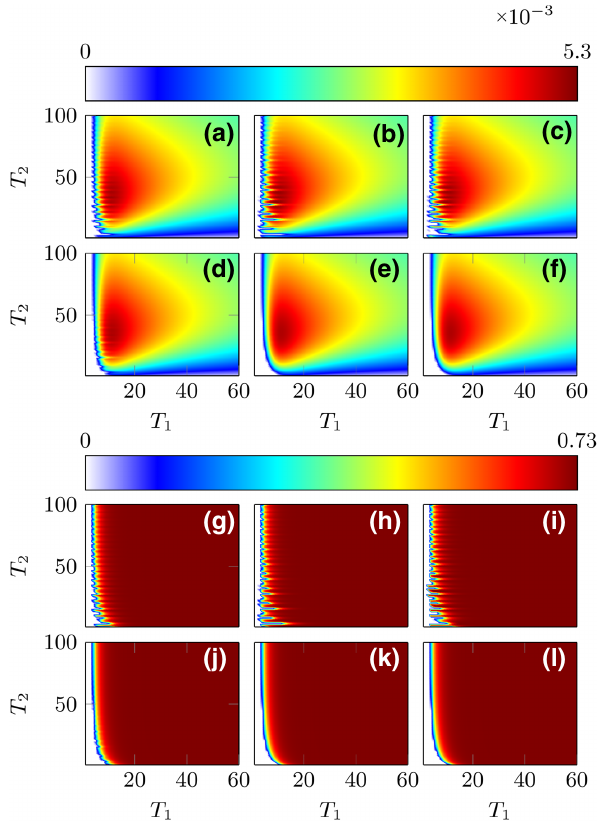
FIG. 5. Power per cycle (a)–(f) and average efficiency (g)–(l) as a function of work and heat-stroke durations T 1 and T 2 with cycle number N = 1 (a),(d),(g), and (j), N = 20 (b),(e),(h), and (k), and N = ∞ (c),(f),(i), and (l); see Appendix B. (a)–(c) and (g)–(i) are for the engine measured via repeated contacts whereas the other panels are for repeated measurements. The white region in all panels correspond to the dud regime of the engine. The extended dark red regions in (g)–(l) indicate regimes with effi- ciencies close to the ideal Otto engine value 1 − (cid:11) c /(cid:11) h ≈ 0.73. Fixed parameters are (cid:11) c = 1, (cid:11) h = 3.7, θ = (cid:11) c τ c = (cid:11) h τ h = 8, = 0.25, β = 0.025, γ = 0.025, and (cid:6) = 0.2. The engine β c h